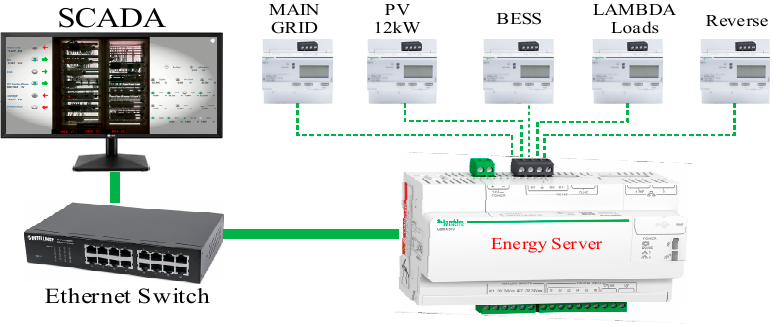
Figure 7. CEMS based on Com’X 510 in LAMBDA MG